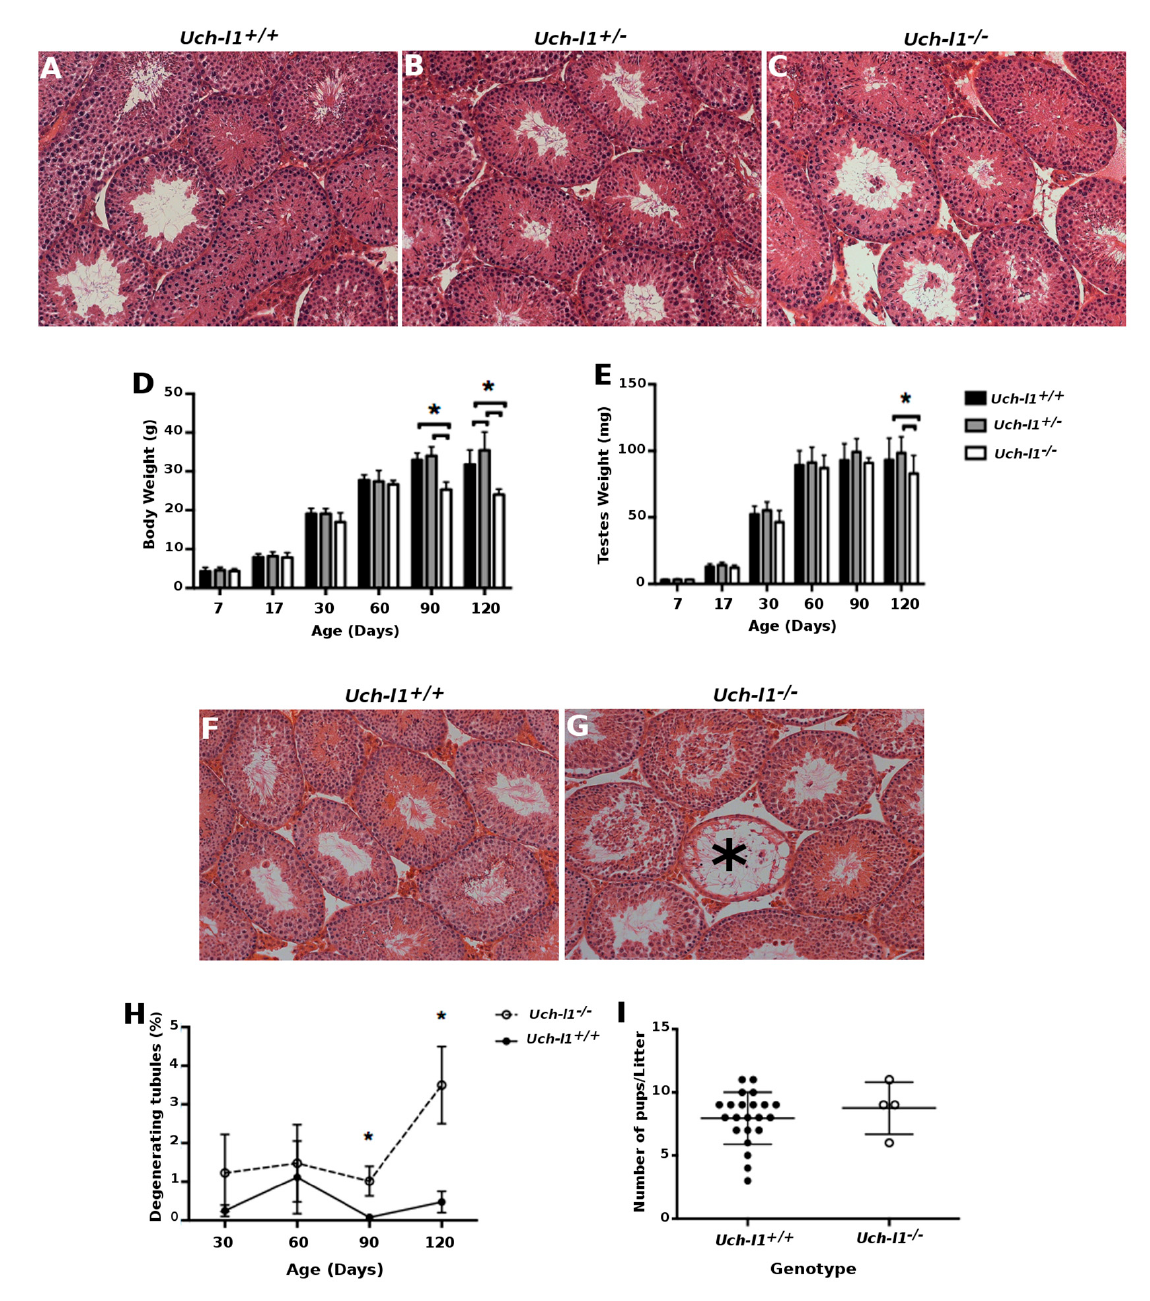
Figure 2. Phenotype of Uch-l1 +/+ , Uch-l1 +/ − and Uch-l1 − / − testes. ( A – C ) H&E histology images of Uch-l1 +/+ , Uch-l1 +/ − and Uch-l1 − / − testes at 120 days old. Scale bar = 200 µ m. ( D ) Body weight of Uch-l1 +/+ , Uch-l1 +/ − and Uch-l1 − / − mice. ( E ) Weight of Uch-l1 +/+ , Uch-l1 − / − and Uch-l1 − / − testes. ( F , G ) 120-day old Uch-l1 +/+ and Uch-l1 − / − testis histology, respectively. Star indicates a degenerating seminiferous tubule. Scale bar = 200 µ m. ( H ) Percentage of degenerating seminiferous tubules at 30, 60, 90 and 120 days of age in Uch-l1 +/+ and Uch-l1 − / − testes. N = 6/genotype/time point. ( I ) Litter size from Uch-l1 +/+ and Uch-l1 − / − male matings to Uch-l1 +/+ females. Individual data points represent one litter. * indicates significant differences ( p < 0.05).